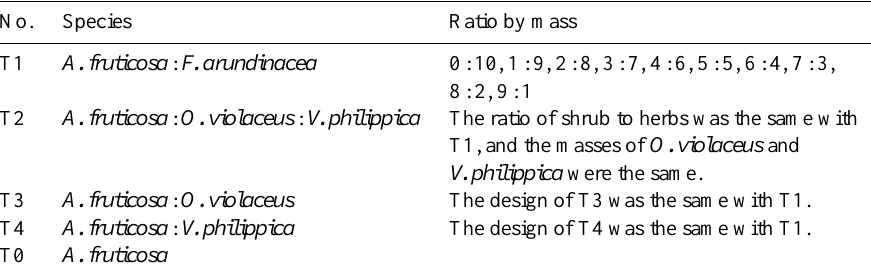
Table 3. Designs of seed